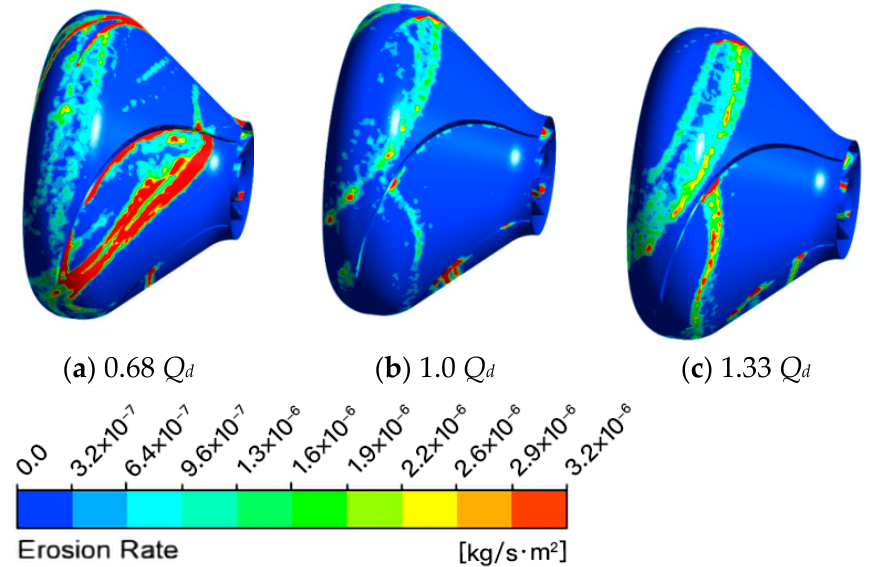
Figure 18. Wear distribution on surface of the guide vanes. Figure 19 shows the change law of the average wear rate on the two-stage impeller- guide-vane surface under the three flow conditions.